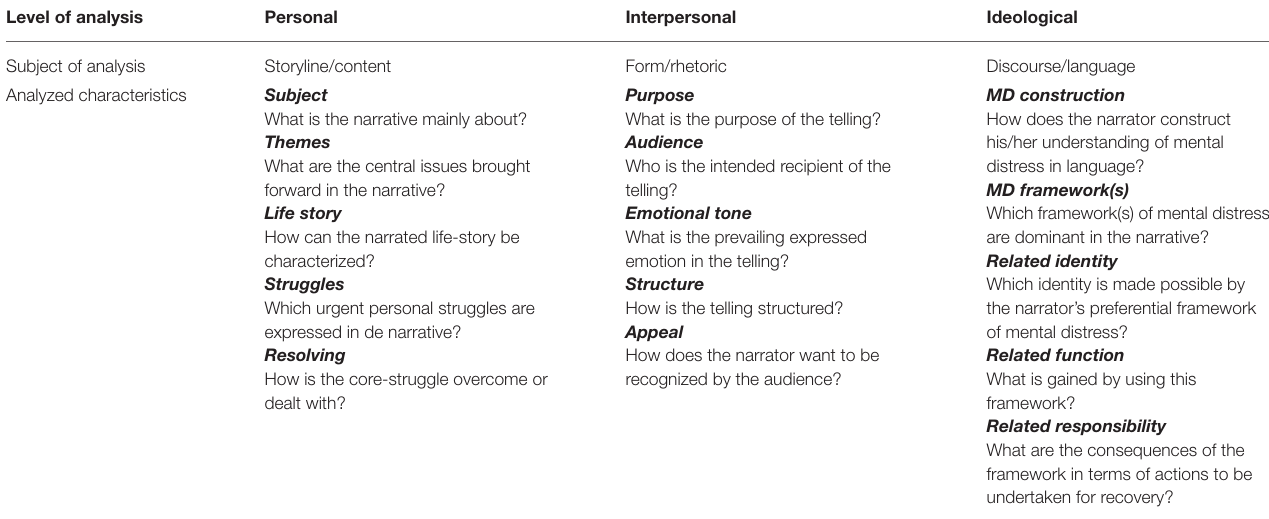
TABLE 2 | Analytical framework.